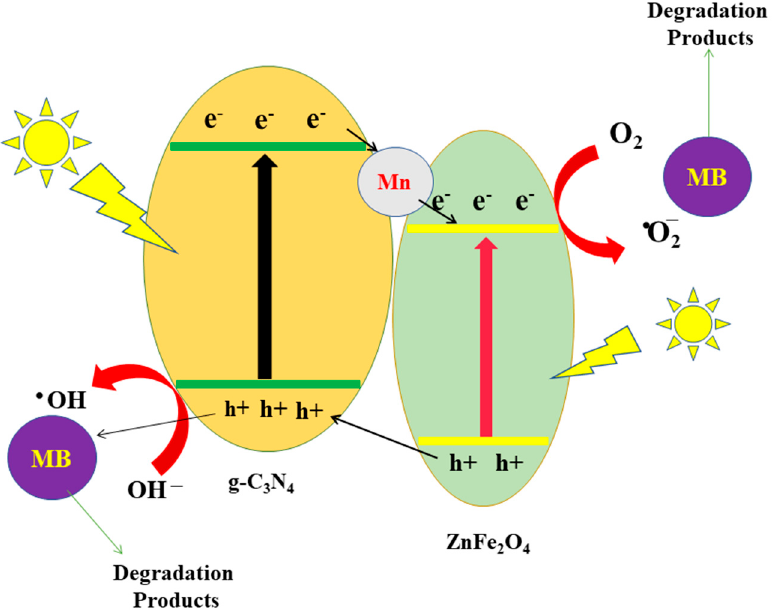
Figure 8. A schematic MB sunlight catalytic degradation mechanism over the Mn-ZnFe 2 O 4 /S-g-C 3 N 4